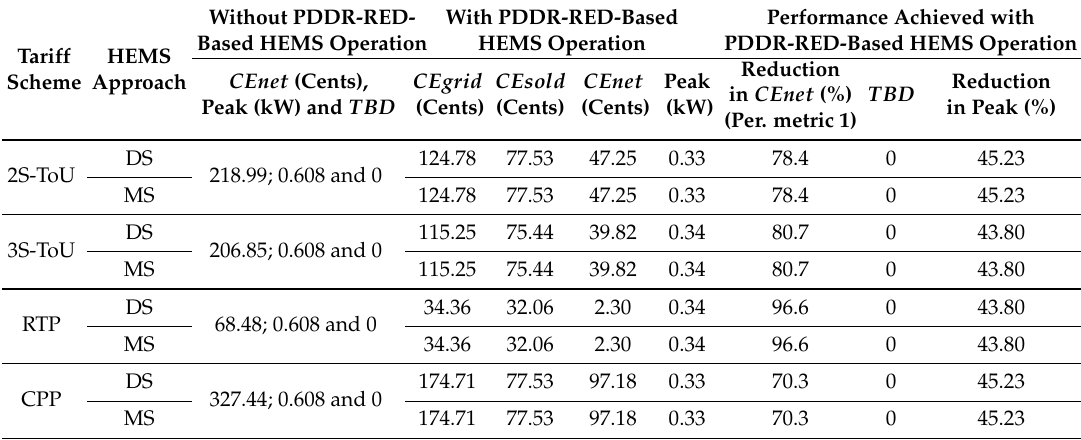
Table 8. DWS-PSO for RED-based HEMS: reductions in CE and PEAK load for diversified TPs using weights ( CE , TBD ) = (0, 1) for minimal TBD